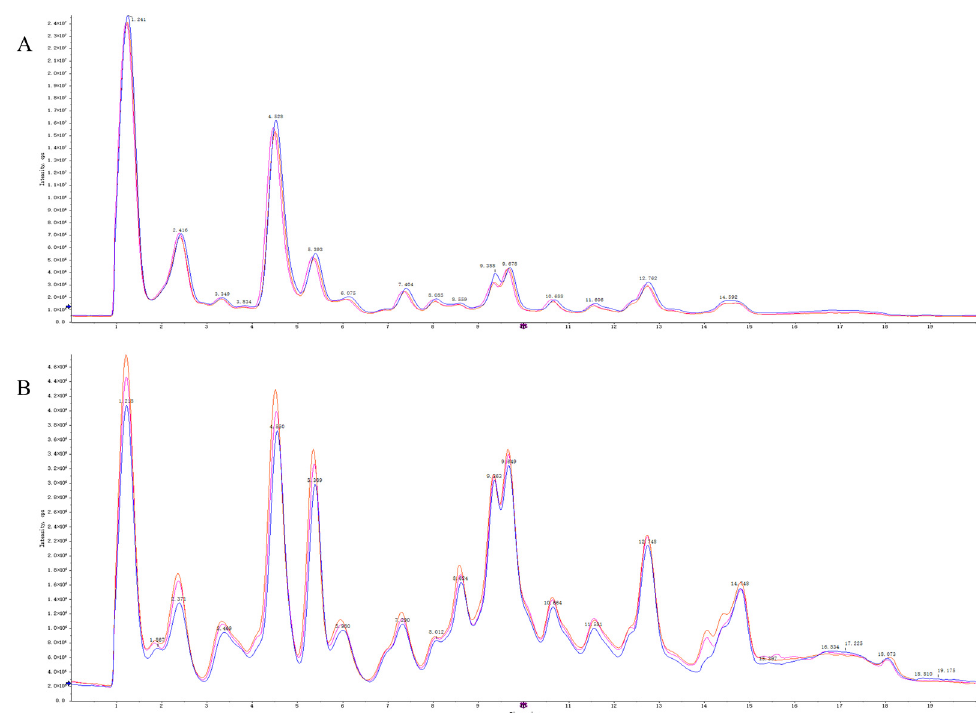
Figure 5. The TIC overlaps of QC samples of in ESI + mode ( A ) and ESI ‐ mode ( B ).